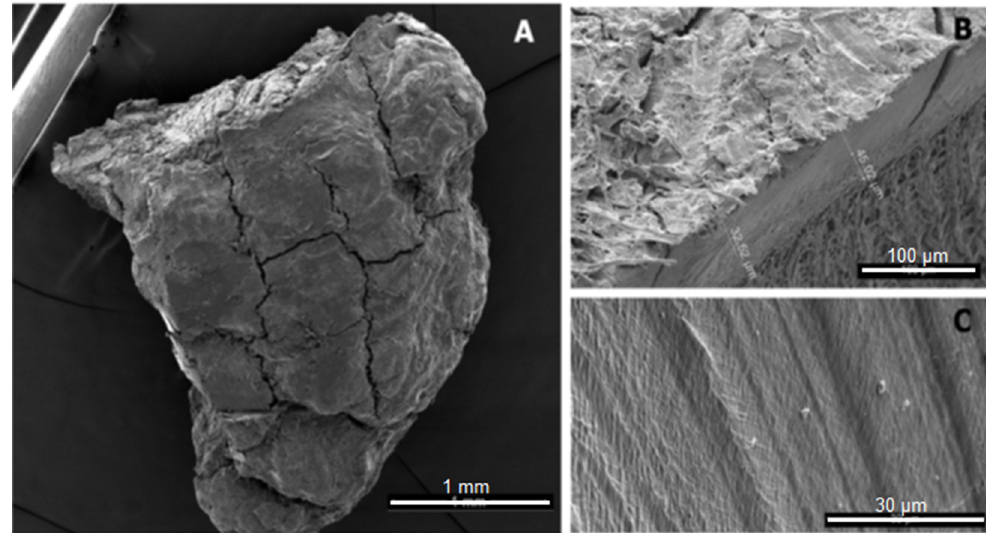
Figure 1. SEM image of a microplastic particle ( A ), mesoplastic ( B ), and a PE film ( C ) found by ter Halle et al, 2016, Reprinted with permission from ref. [40], Copyright 2016, American Chemistry Society.